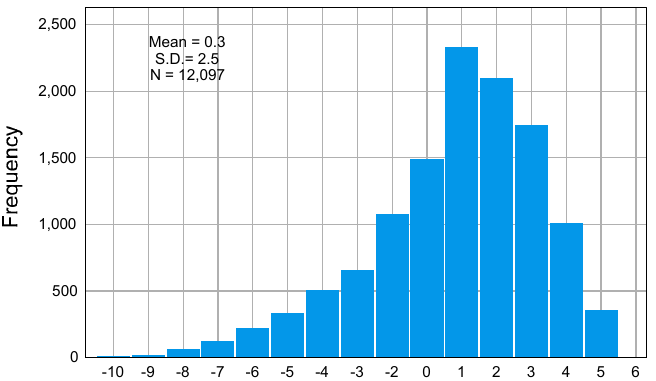
Figure 20. Difference between the indoor air temperature and the balcony air temperature with green curtain and without air-conditioner usage in July and August.